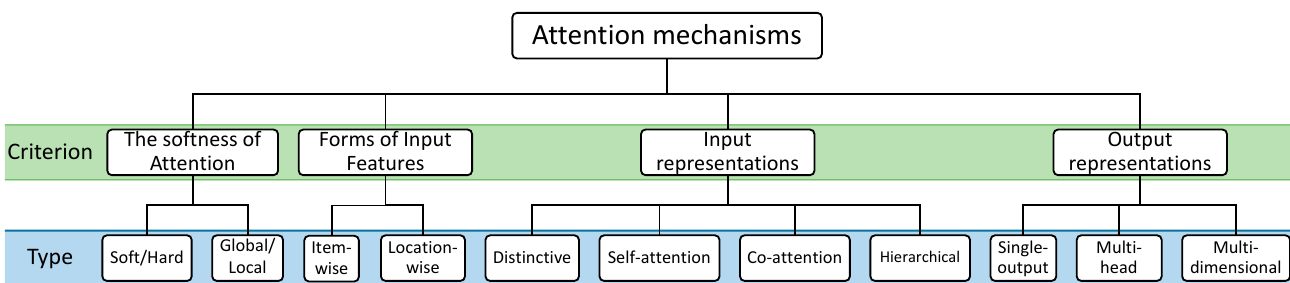
Figure 1. An overview of typical attention mechanism approaches [21].